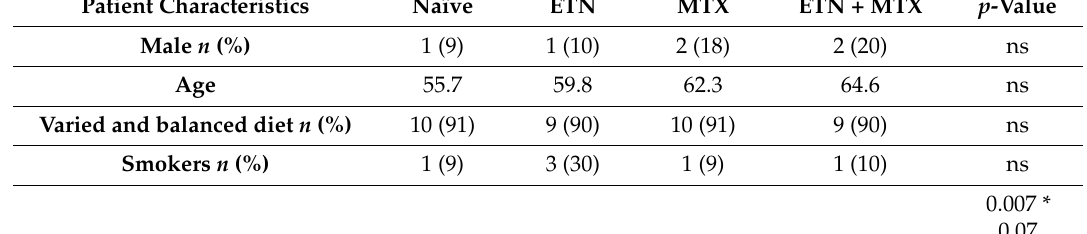
Table 1. Main demographic, clinical, and serologic data of the 42 rheumatoid arthritis (RA) patients. Patient Characteristics